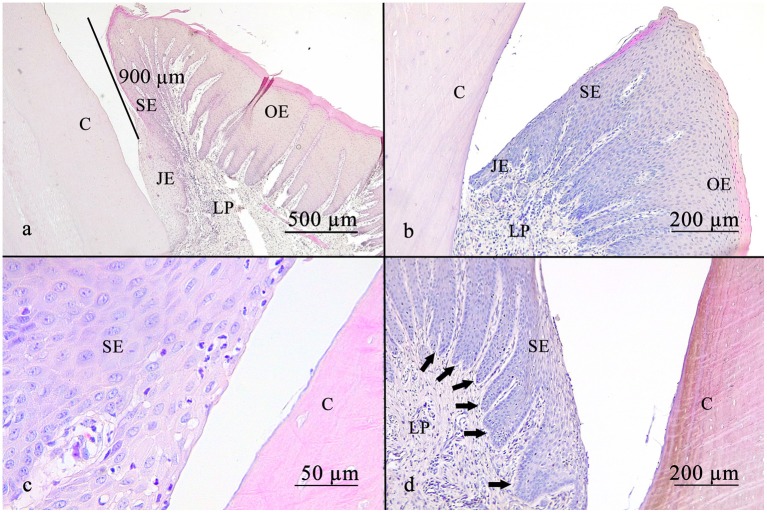
The gingival sulcus was measured from the gingival margin to the suspected bottom of the gingival sulcus (a). The average depth was <1 mm. The sulcular epithelium is a non-keratinized epithelium (b). Leucocytic infiltrates are able to get through the sulcular epithelium, as shown in (c). Rete pegs are visible (d) (arrows). C, cementum; JE, junctional epithelium; SE, sulcular epithelium; OE, oral epithelium; LP, lamina propria.